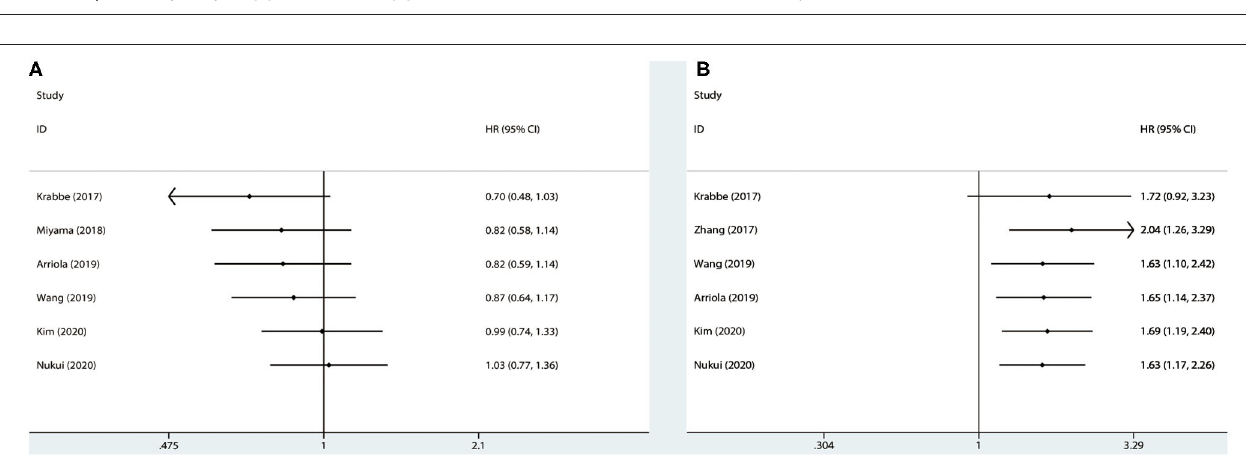
appropriate therapies, we should also take clinicopathological and adverse effects into